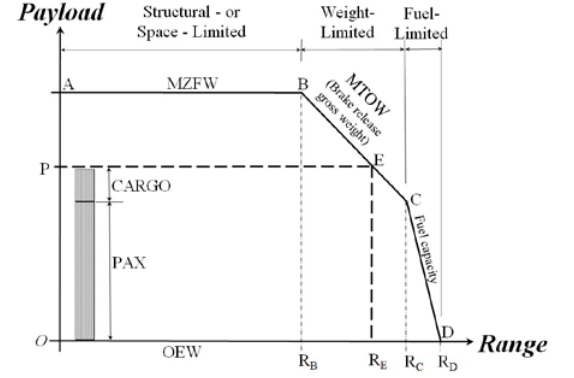
Fig. 1. Generic payload-range envelope for a typical civil